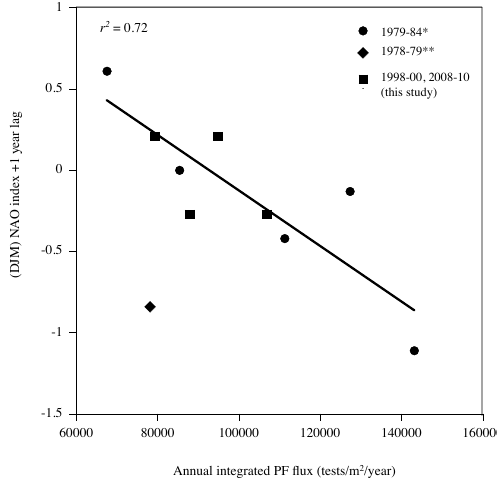
Figure 11. Annual integrated PF flux from this study (1500m trap, square symbols) and 1979–1984 (*3200m trap, round symbols, Deuser, 1987; Deuser and Ross, 1989) plotted against wintertime (DJFM) NAO index + 1-year lag. Annual fluxes from both trap depths are comparable. **Annual PF flux from 1978 (diamond sym- bol) was not included in the regression because it was an anoma- lously low flux year which could be explained by a shallow MLD and/or possibly the presence of an anticyclonic eddy (no data to test), which may have suppressed the spring bloom and hence PF flux as seen during 1994 at BATS (Lomas et al., 2013). NAO data available at